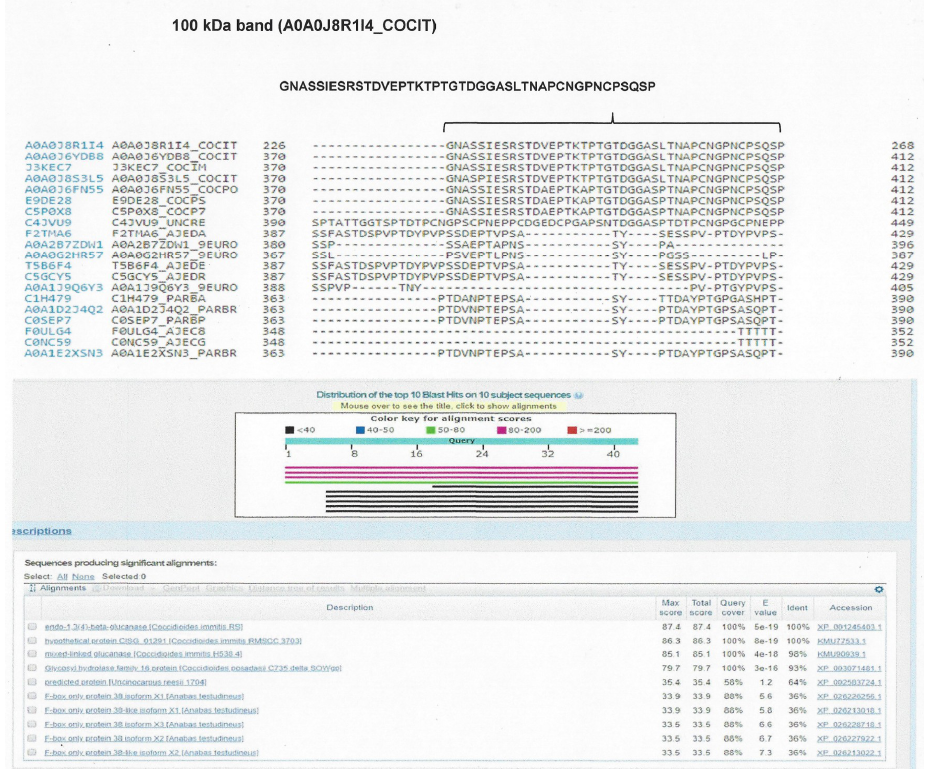
Figure 4. Alignment map with the BLAST protein program. The selected peptide of the assembled protein corresponding to the 100 kDa band is shown, identified through aligned sequences of Coccidioides spp. and related fungi. The selected peptide was compared through the BLAST program to confirm its